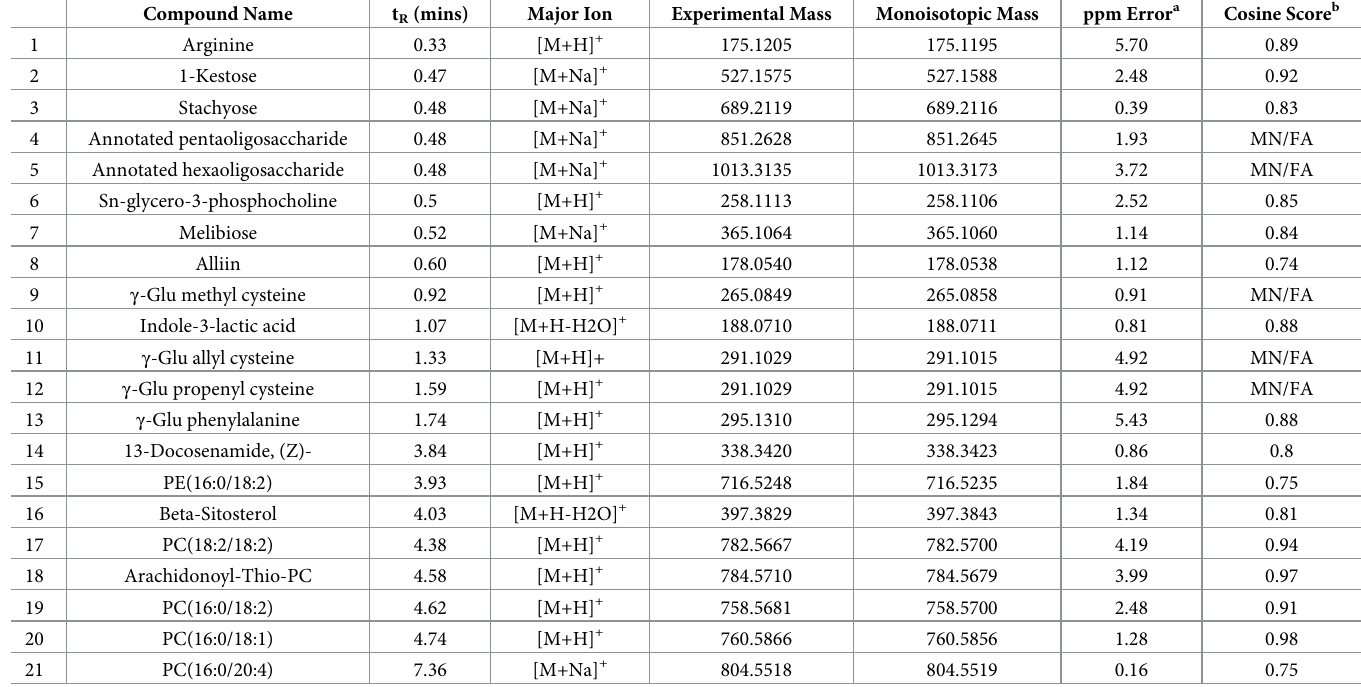
Table 1. Secondary metabolites putatively annotated from authenticated BAU and ILAU garlic through GNPS analysis. Compound